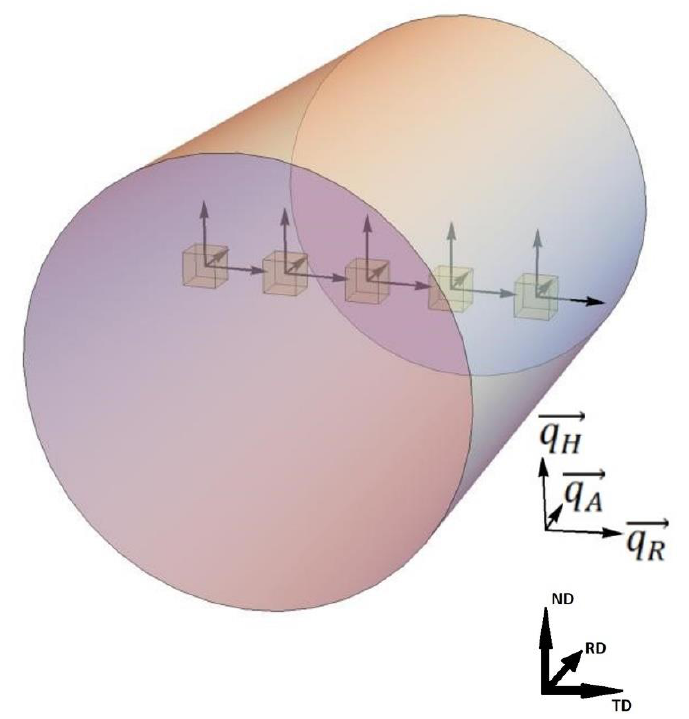
Figure 1. Scheme of the ND scans.